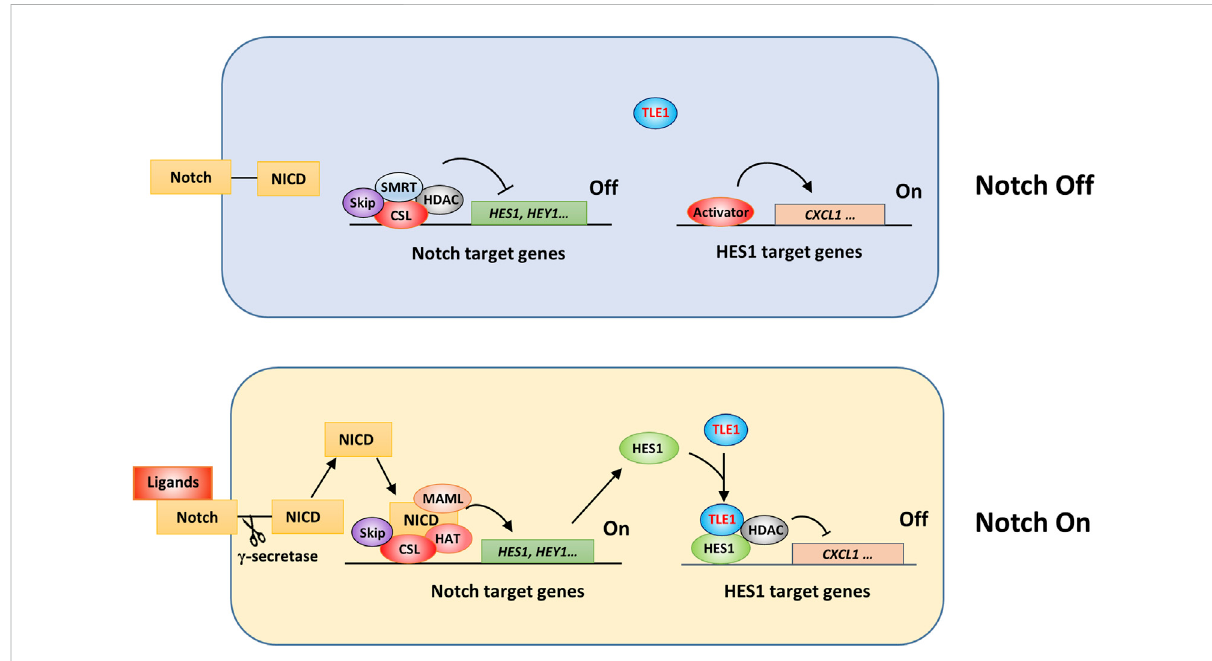
FIGURE 3 Schematic showing TLE1 regulation of Notch activation effects. In Drosophila , corepressor Gro and CtBP proteins are involved in the transcriptional suppression of Notch target genes (Nagel et al., 2005; Guo et al., 2019). In mammalian cells, Notch target gene expression might be inhibitedbyasuppressivecomplexcomprisingCSL,thecorepressorSMAT/Skip,andhistonedeacetylases(HDACs)intheabsenceofNotchsignaling activation (Notch off). Upon Notch activation (Notch On), an activation complex consisting of CSL, NICD, MAML, and histone acetyltransferase (HAT) is assembled to drive the expression of Notch target genes. The interaction of HES1 and TLE1, and likely other TLE members, is critical for the transcriptional suppression of HES1 target